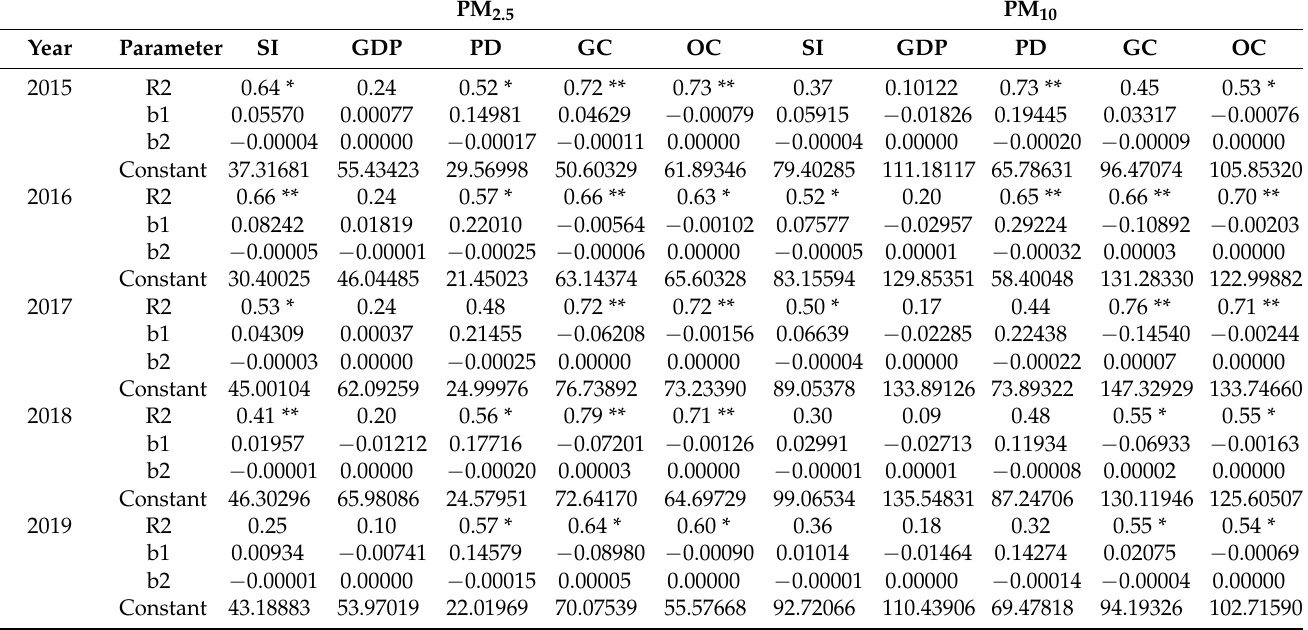
Table 1. Results of curve